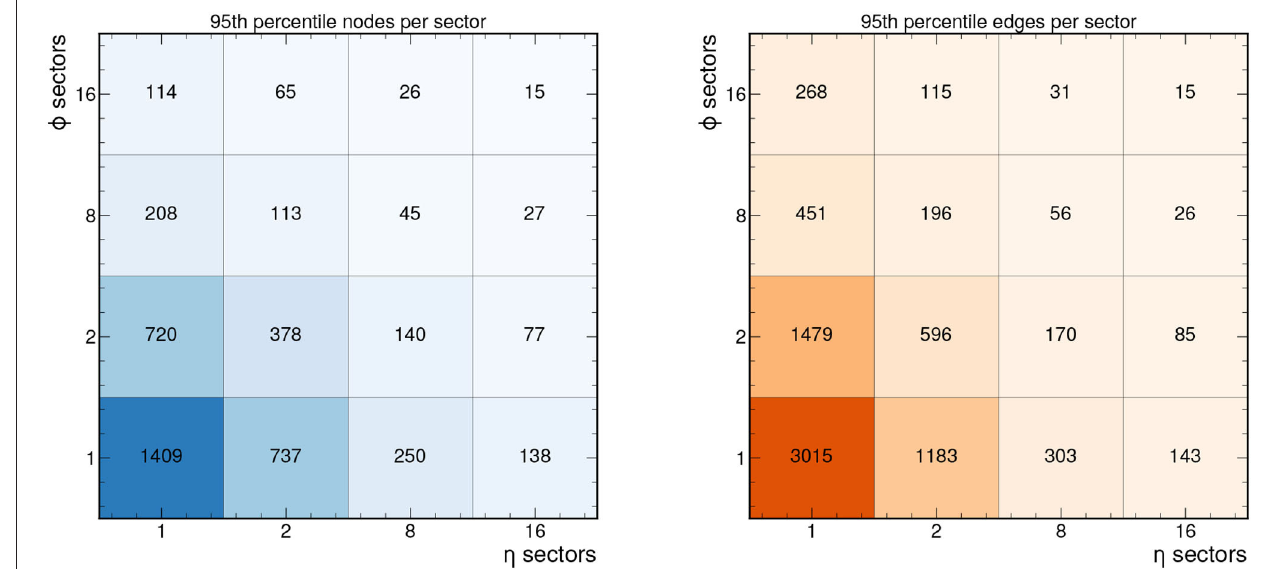
FIGURE 4 | 95th percentile of the number of nodes and edges in each sector for the 2GeV graphs as a function of the number of η and φ sectors, based on 50 events in train_1